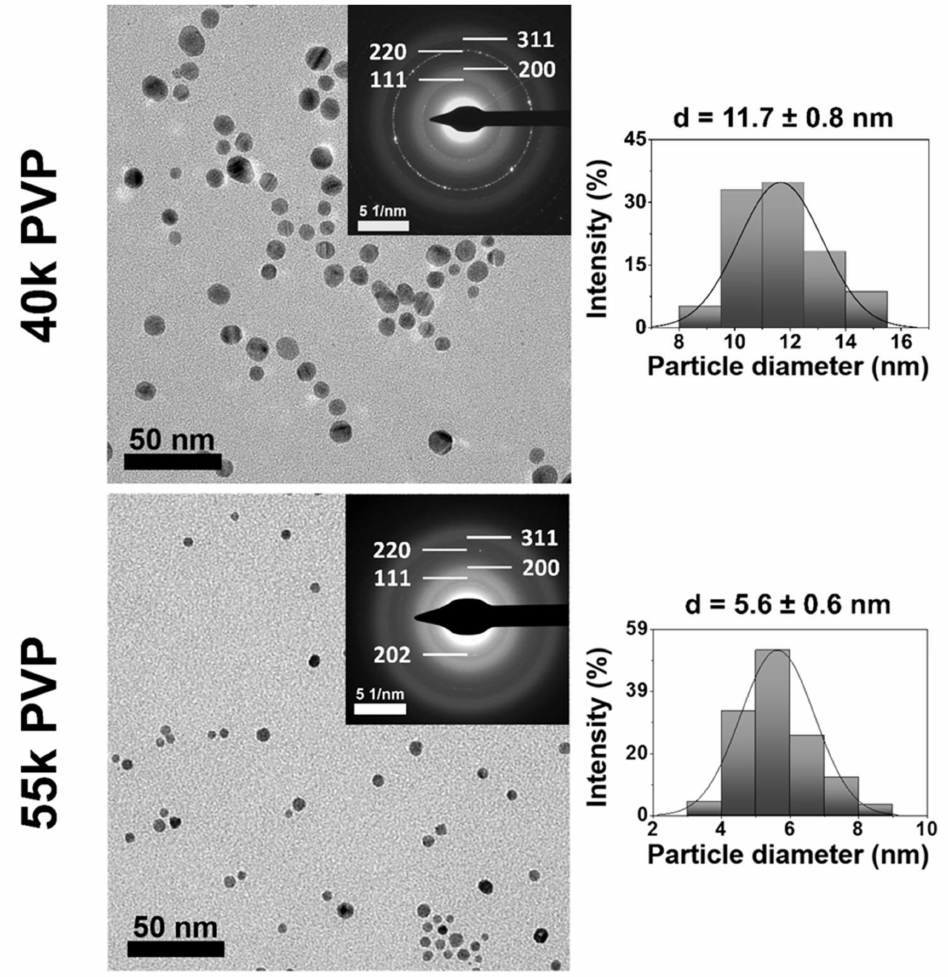
Figure 1. Transmission electron microscopic (TEM) images, electron diffraction (ED) patterns, and size distribution histograms of silver nanoparticles stabilized by 40k (top) and 55k (bottom) molecular weight